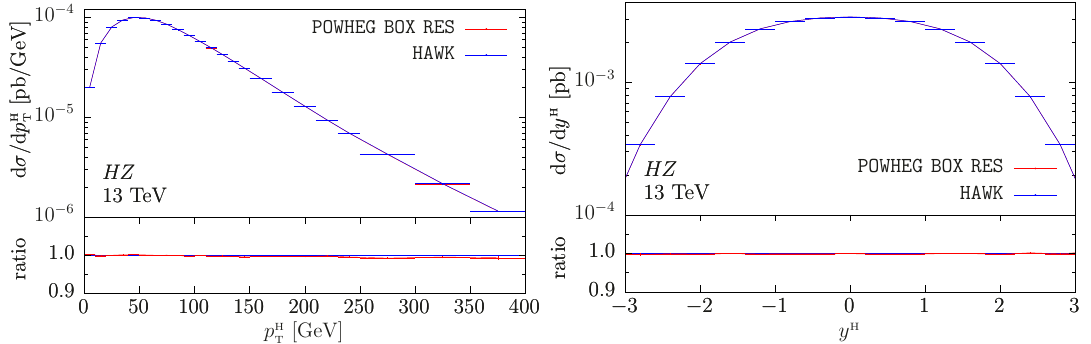
Figure 30. NLO EW predictions for the transverse momentum (left) and the rapidity (right) of the Higgs boson in HZ production. Comparison between the POWHEG BOX RES and the HAWK predictions.